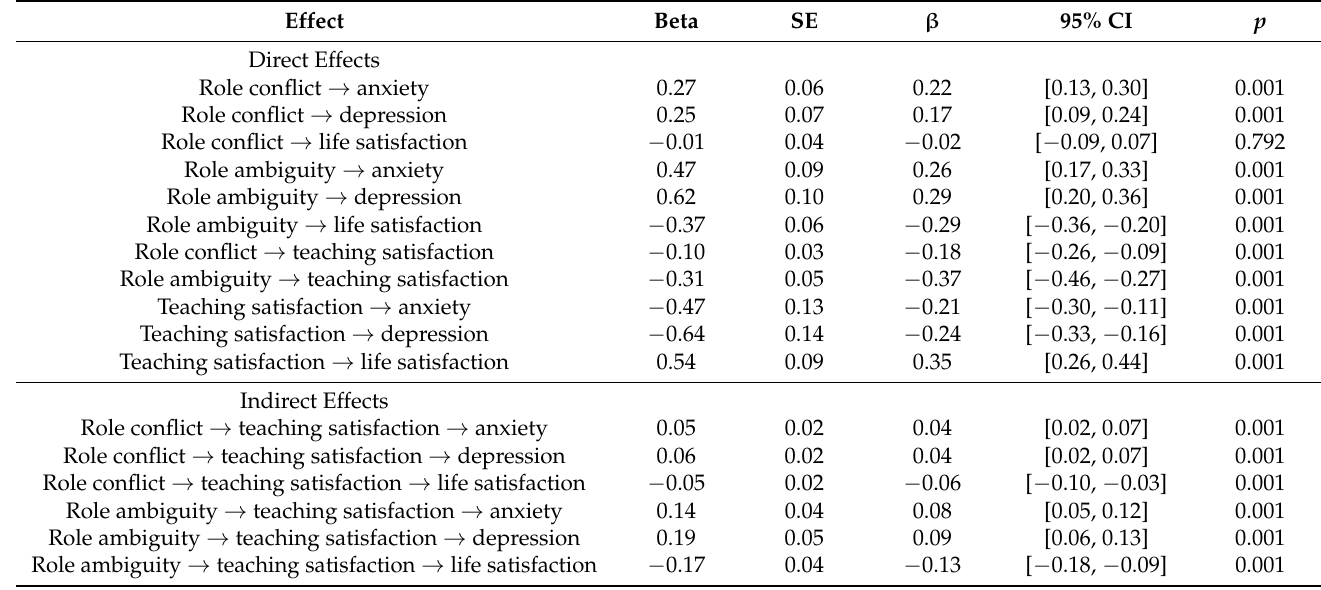
Table 2. Direct and Indirect Effects of Role Stress on indices of Psychological Well-Being.